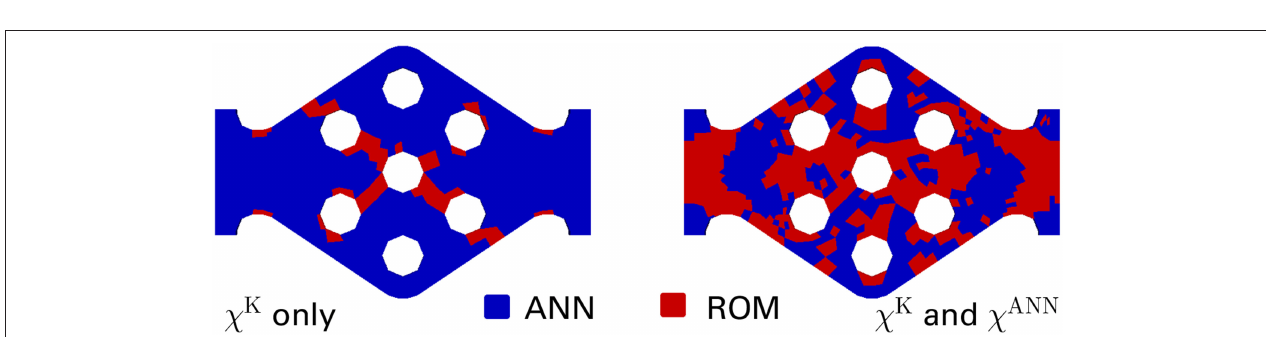
FIGURE 10 | Comparison of the final quality indicators at the end of the adaptive simulation for mesh M1: kinematic classifier only (Left) vs. hybrid classifier accounting for the ANN accuracy cf. section 3.2.2 (Right) .